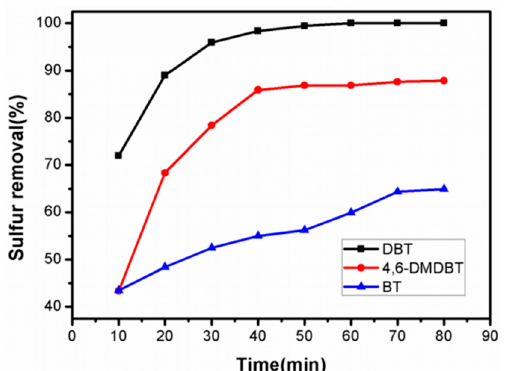
Figure 7. The catalytic oxidation results for DBT, 4,6 ‐ dimethyldibenzothiophene (DMDBT), and benzothiophene (BT). Conditions: Model oil = 5 mL, n ([Bmim] 5 PMo 11 Co(H 2 O)O 39 ) = 4 μ mol, n (H 2 O 2 )/ n (DBT) = 5, T = 50 °C, with [Omim]BF 4 (1 mL) as the extractant.